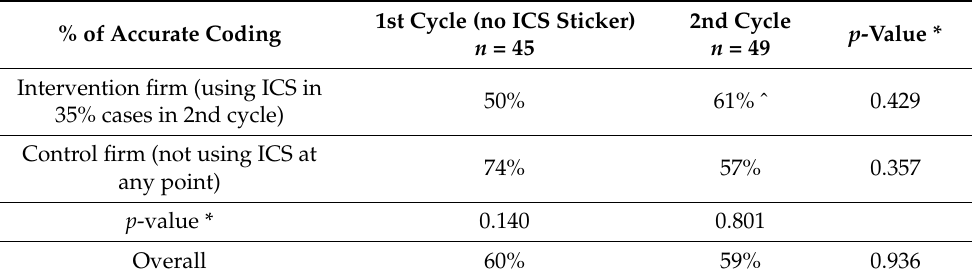
Table 3. Comparison between accuracy of clinical coding for each firm during 2 cycles. % of Accurate